Question: What does this figure show? Answer in one sentence.
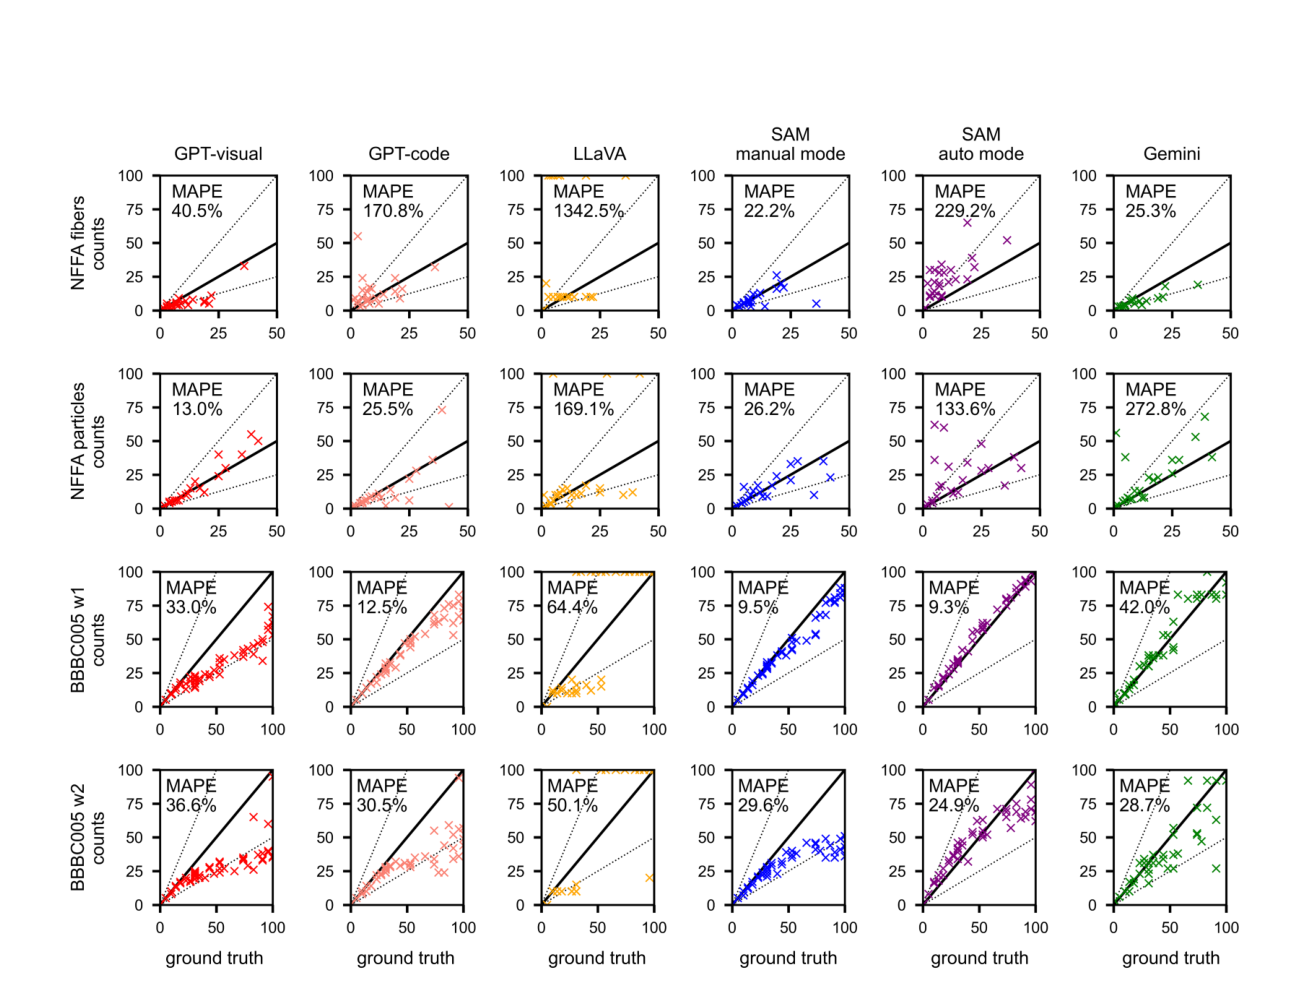
Answer: Predicted fiber, particle, and cell counts for sampled data, i.e. NFFA-MS (fibers and particles) and BBBC005-S (w1 and w2), plotted against the actual counts, for ChatGPT, LLaVA, SAM (using standard parameters for NFFA and custom for BBBC005, and used in either manual or automatic counting mode), and Gemini models. Mean absolute percent error (MAPE) is included for quantitative comparison. Ground truth for NFFA datasets refers to the manual count performed by the domain expert.